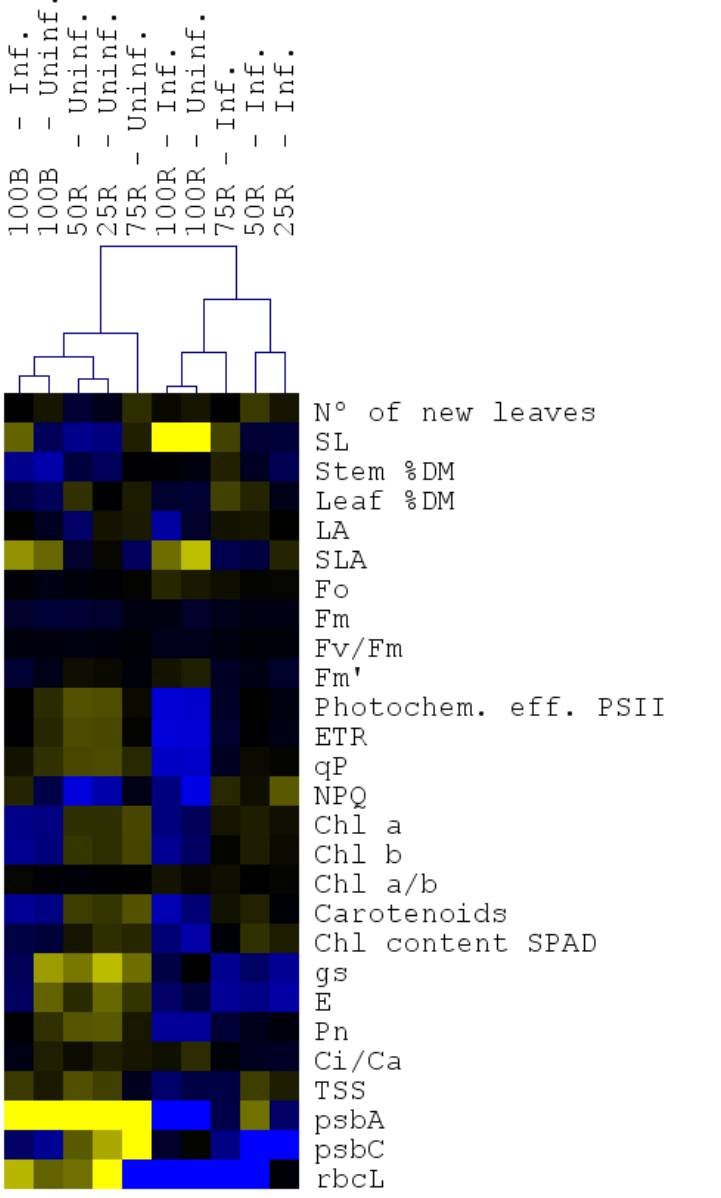
Figure 7. Hierarchical clustering of all parameters evaluated in the different light treatment. Clusters were generated using MeV with values normalized with the respective white light controls. Normalized values based on 100 W (uninfected or infected) data were used for hierarchical clustering based on Pearson’s distance metric. The color scale represents higher (yellow) or lower (blue) values with respect to the 100W.